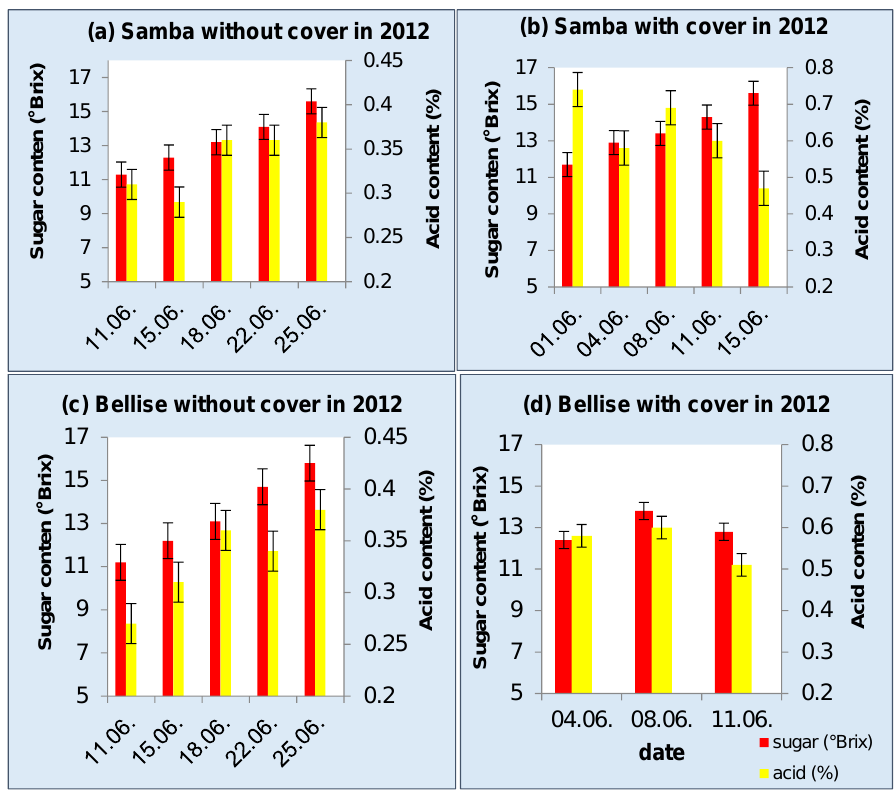
Figure 2. Sugar and acid content in 2012 of cv. “Samba” without ( a ) and with cover ( b ) and “Bellise” without ( c ) and with cover ( d ) (N.B. right-hand axis has different scaling, depending on treatment).